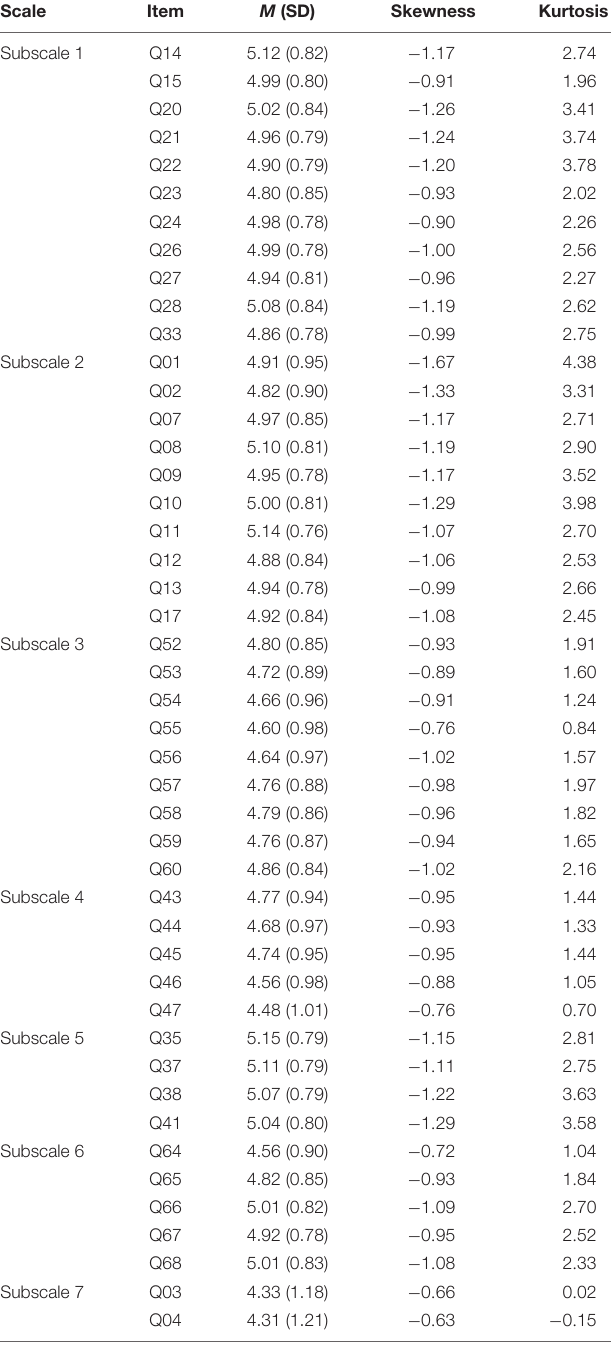
TABLE 2 | Descriptive statistics of the original seven-factor 46-item Service Leadership Attitude Scale (SLA-SF-46E). Scale